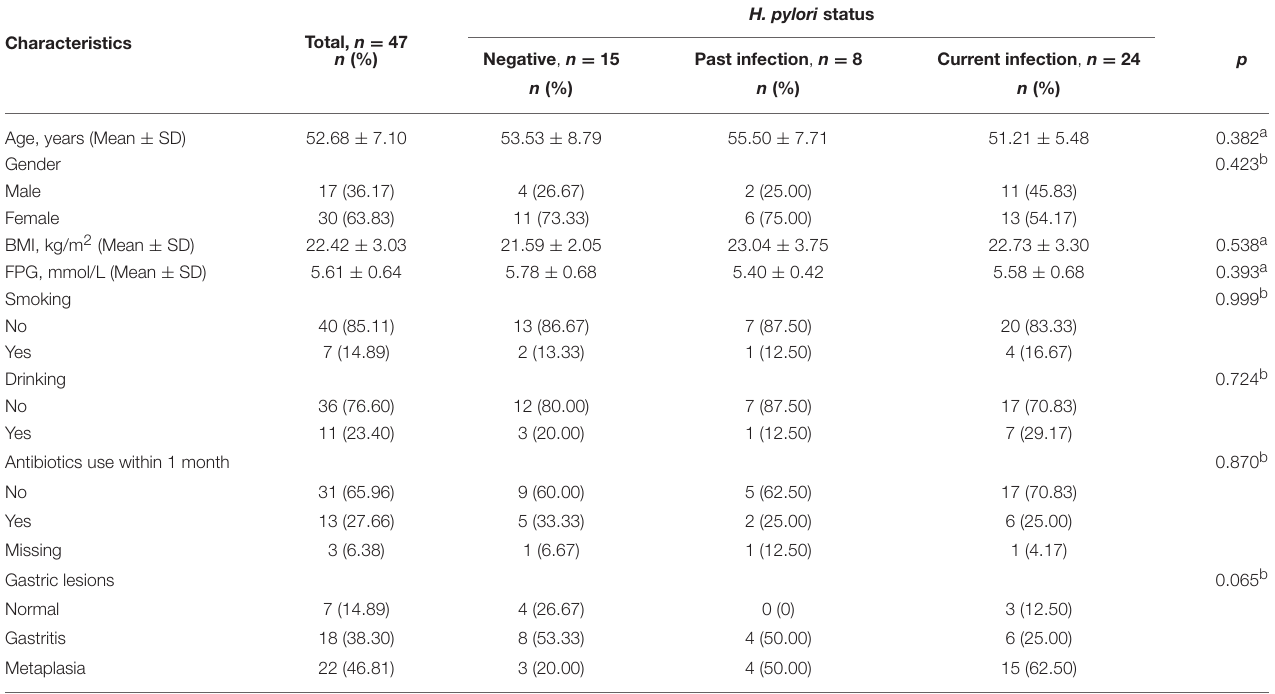
TABLE 1 | Characteristics of the participants included in this